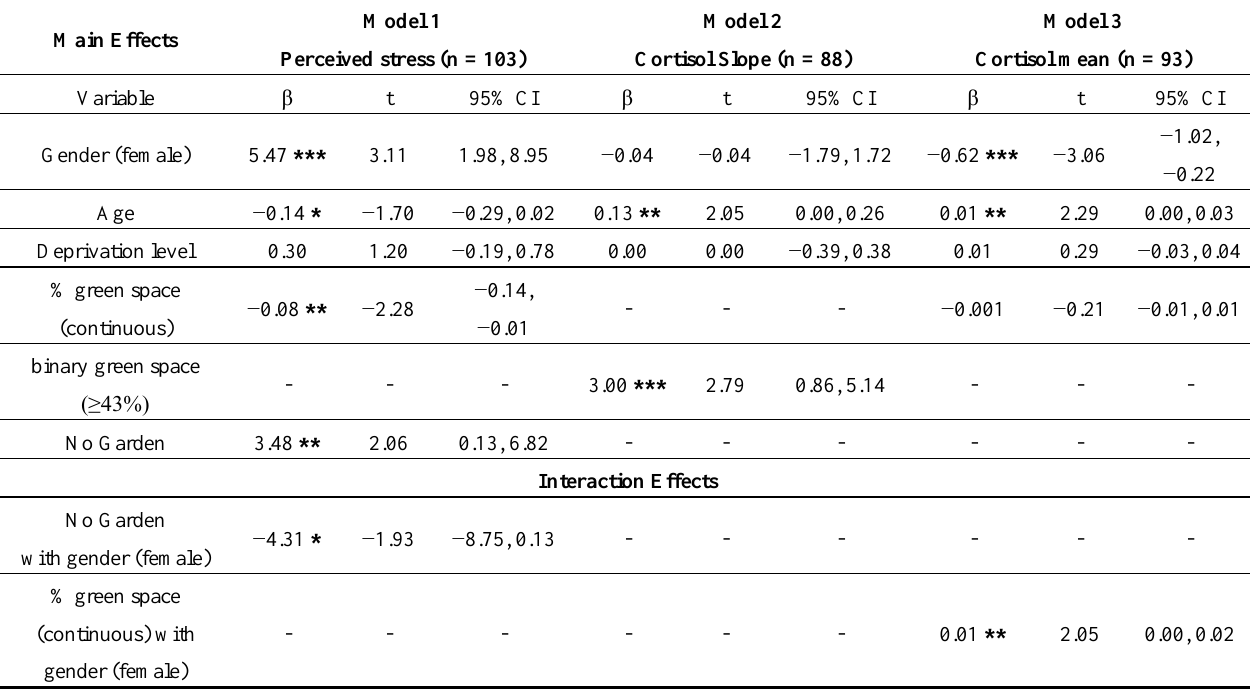
Table 4. Linear regression model analyses predicting perceived stress, cortisol slope and cortisol mean over 2